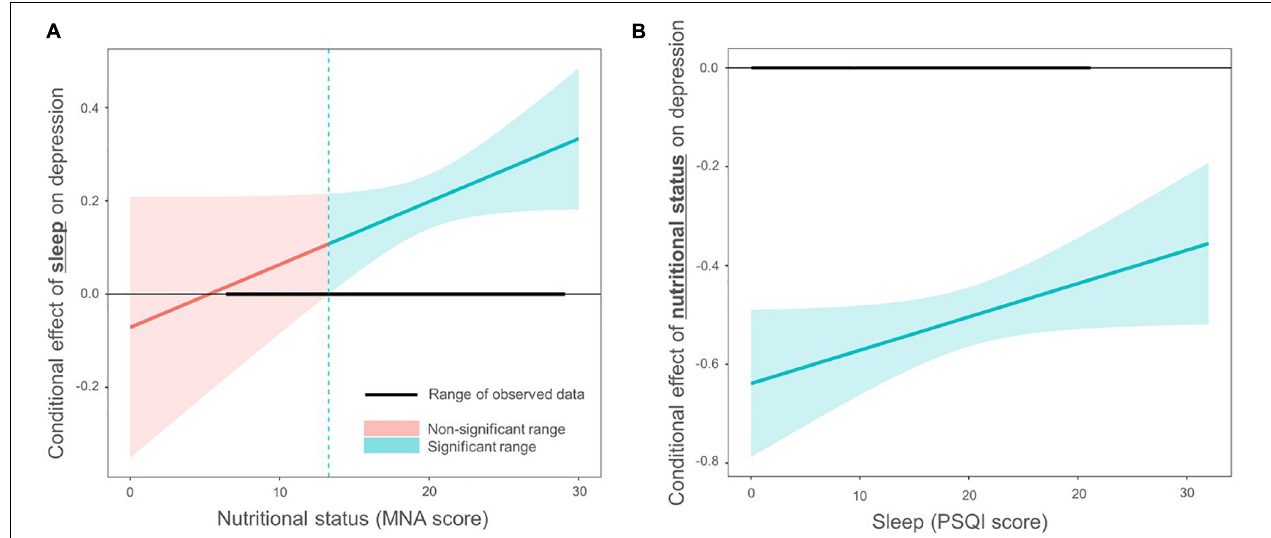
FIGURE 2 | Interaction effects between sleep disturbance and nutritional status in older adults with depression. The Johnson–Neyman technique was employed to examine the interaction effect between sleep disturbance and nutritional status on depression. The y-axis represents the conditional effect on depression. Confidence intervals were displayed in different colors depending on whether they were significant ( P < 0.05). (A) The PSQI score had an insignificant effect on SGDS-K when the MNA score was lower than 14.028, as shown in red. The range of the observed data is shown as a thick horizontal line. (B) The MNA score had a significant effect on SGDS-K regardless of the PSQI score, as shown in blue (n.s., non-significant). MNA, Mini Nutritional Assessment; PSQI, Pittsburgh Sleep Quality Index; SGDS-K, Korean version of the Short Form of Geriatric Depression